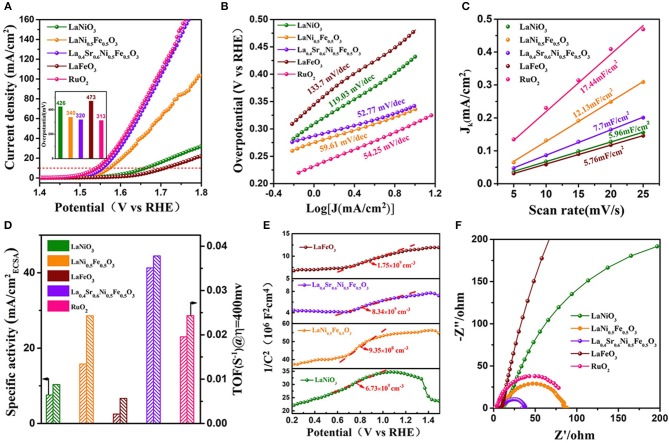
(A) Linear sweeping voltammogram curves of various catalysts (LaNiO3, LaNi0.5Fe0.5O3, La0.4Sr0.6Ni0.5Fe0.5O3, LaFeO3, and commercial RuO2) in 1.0 M KOH at a scan rate of 5 mV s−1; Inset compare the OER overpotential for the corresponding catalyst in (A) at J = 10 mA cm−2; (B) Tafel plots for the corresponding catalysts; (C) Plots of the current density vs. the scan rate to determine the double layer capacitance (Cdl) of various catalysts; (D) Specific activity of various catalysts (OER current density @ 1.6 V vs. RHE normalized by electrochemical surface area) and TOF calculated at overpotential η = 400 mV; (E) Mott-Schottky plots for the corresponding various catalysts; (F) Electrochemical impedance spectra of various catalysts recorded at 1.58 V vs. RHE under the influence of an AC voltage of 5 mV.